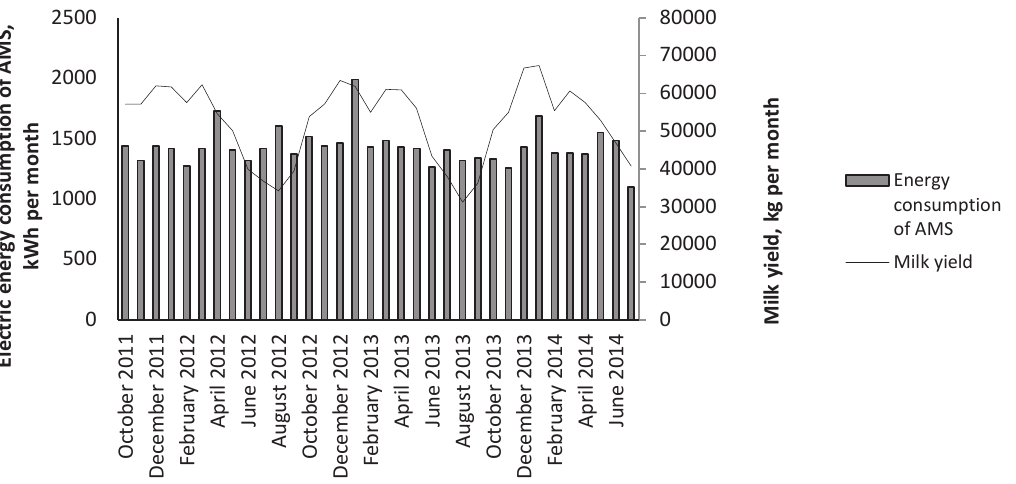
Fig. 2. Monthly electric energy consumption of the milking robot and milk yield with the